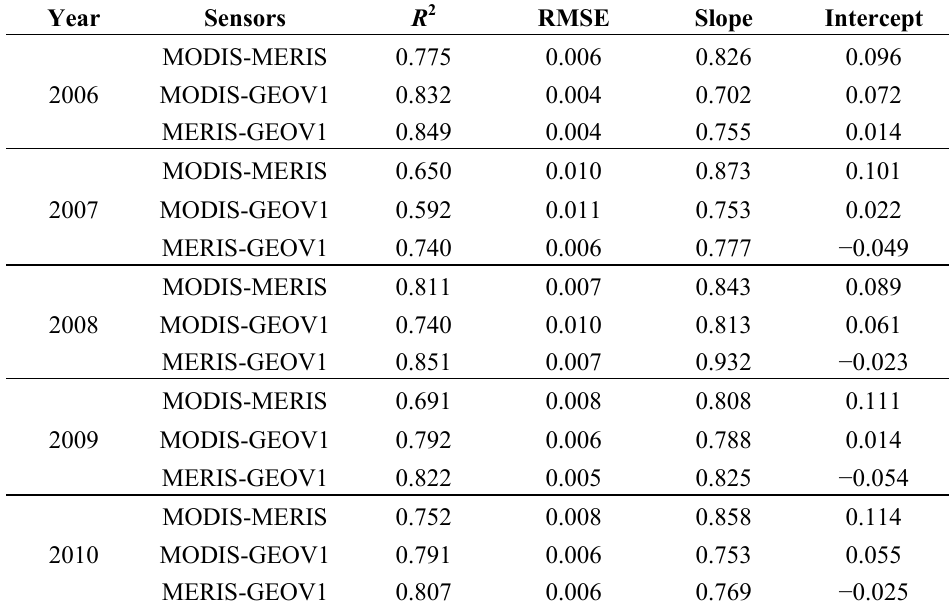
Table A2. Winter wheat FPAR relationships among MODIS, MERIS and GEOV1 products.